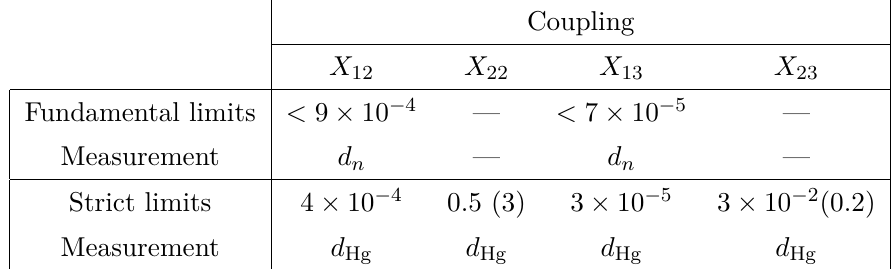
Table 2. Limits on the LQ couplings to fermions coming from EDM measurements in hadrons. We only show the constraints that are more stringent than the ones originating from lepton EDM